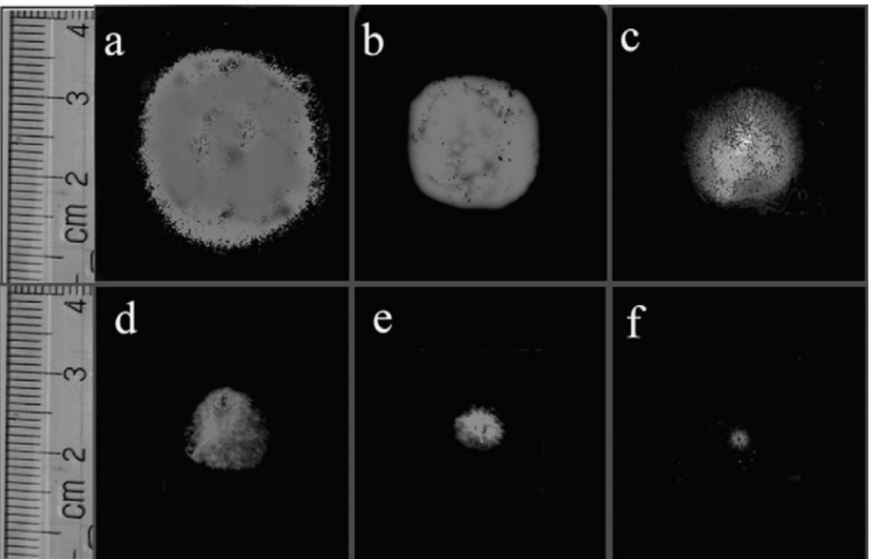
Figure 32. The deposition areas when electrospinning at different parameters. The applied voltage and electrode-to-collector distance are: ( a ) 10 kV and L = 2.6 cm; ( b ) 10 kV and L = 2.1 cm; ( c ) 10 kV and L = 1.7 cm; ( d ) 7 kV and L = 1.2 cm; ( e ) 6 kV and L = 0.8 cm; ( f ) 5 kV and L = 0.5 cm. Reprinted with permission from [105]. Copyright 2008 Elsevier.